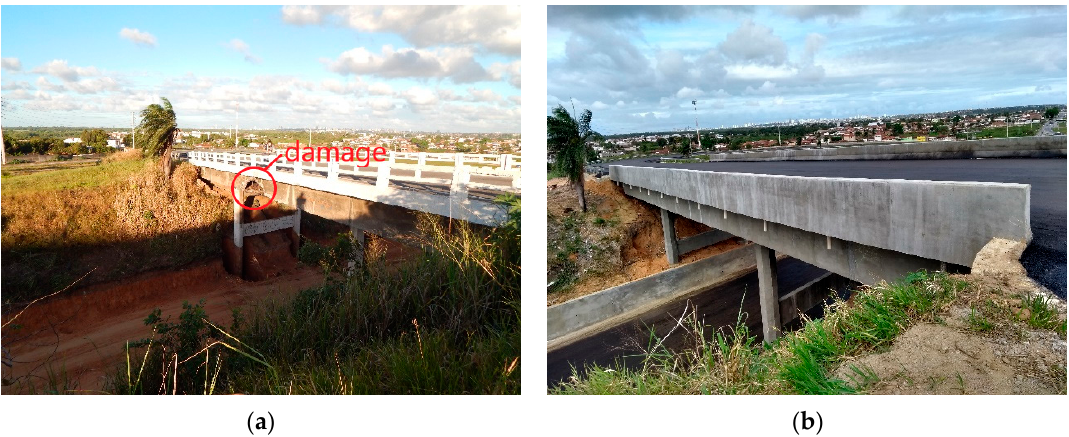
Figure 9. Várzea Nova viaduct. ( a ) Before strengthening. ( b ) After strengthening.